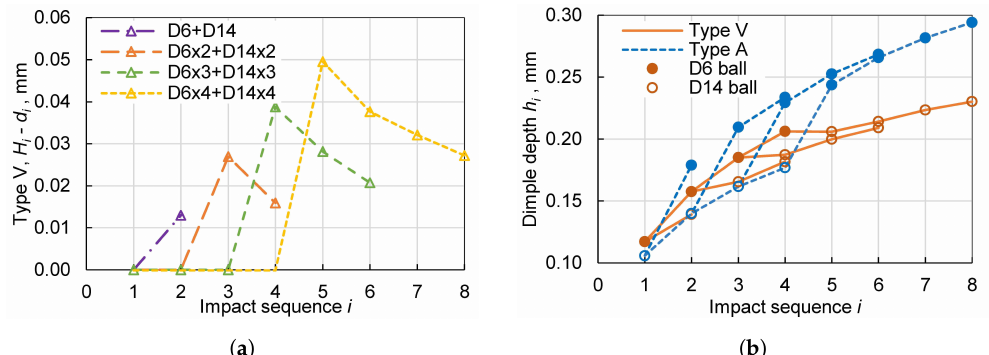
Figure 6. ( a ) Gap between tool tip and dimple apex at bottom point of hammering and ( b ) residual dimple